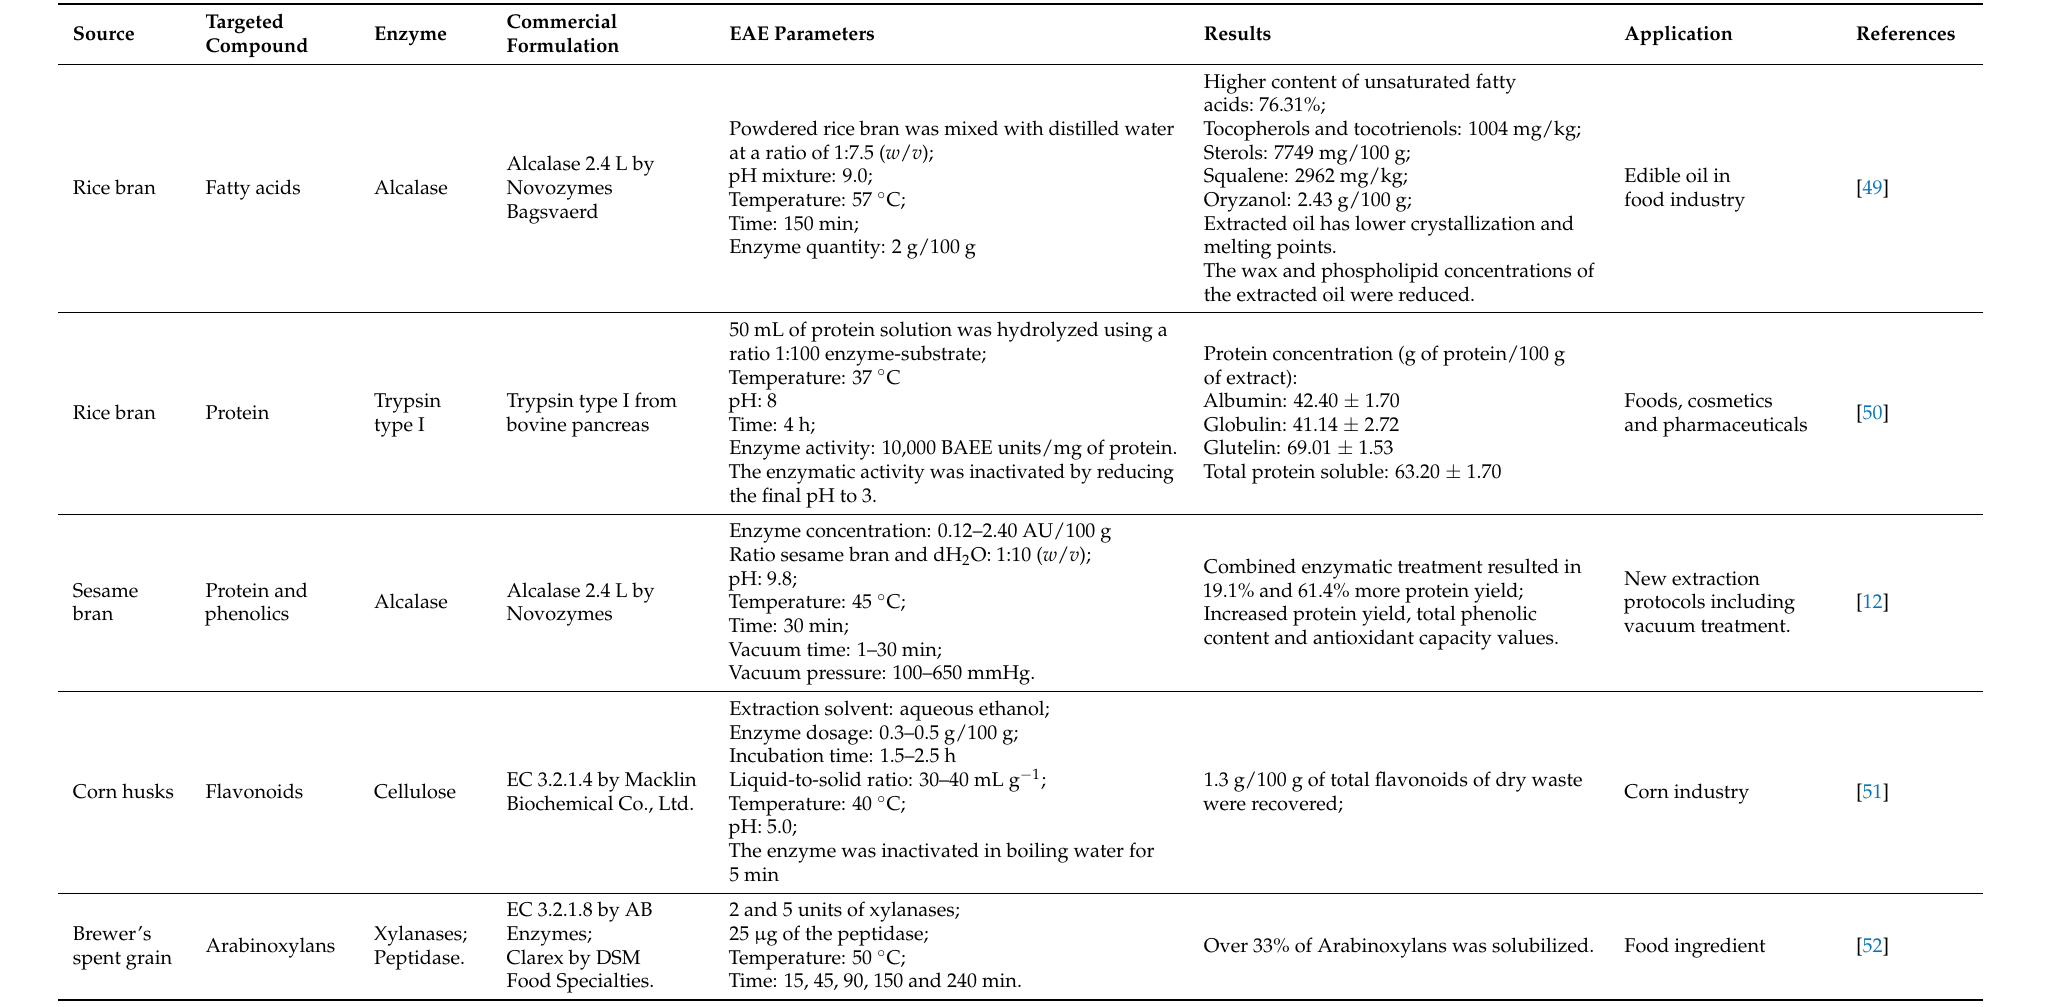
Table 2. Summary of EAE ( Enzymatic-assisted extraction) for the extraction of bioactive compounds from cereal